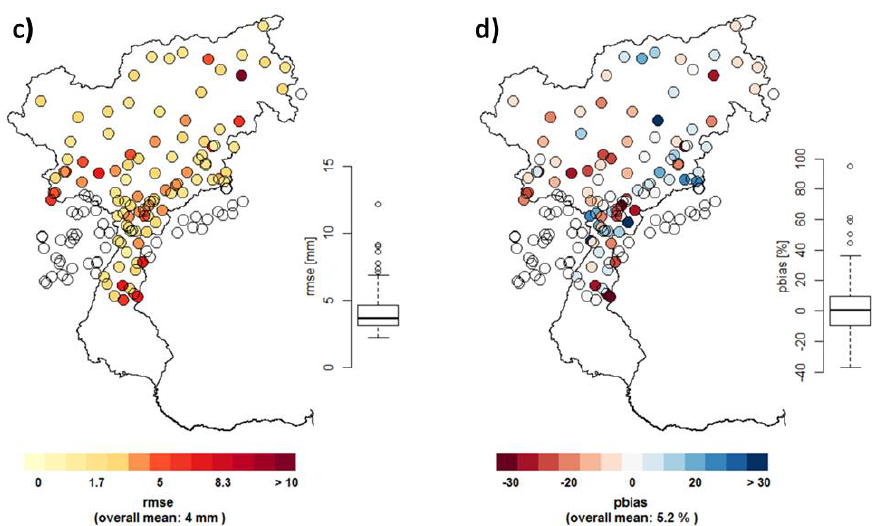
Figure 3. Evaluation of interpolation performance at various precipitation stations over the Adige catchment. Assessment through the indicators: MAE* ( a ); Mean Absolute Error (MAE) ( b ) and Root Mean Square Error (RMSE) ( c ); and Percent Bias (PBIAS) ( d ). Stations outside the catchment are masked.